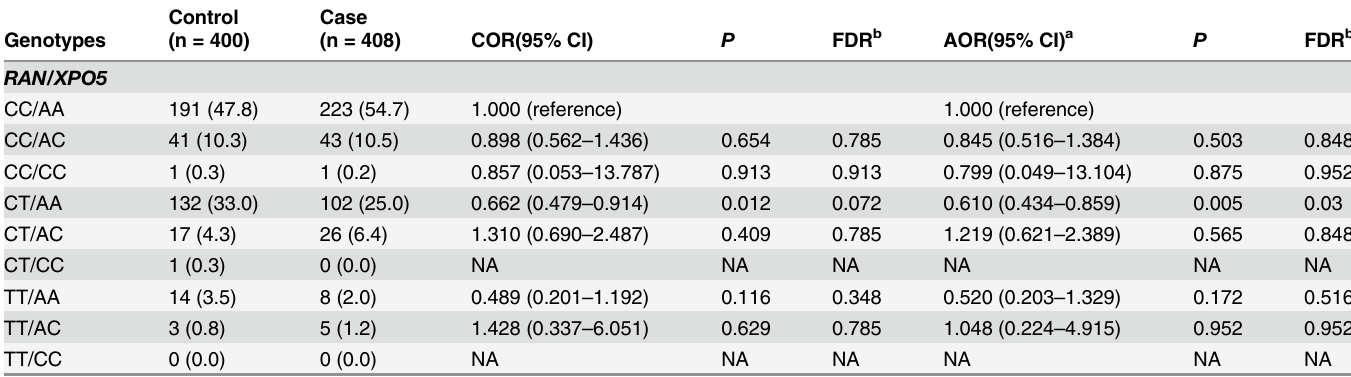
Table 4. The combination of miRNA machinery genes polymorphisms based on MDR and CRC patients. Control